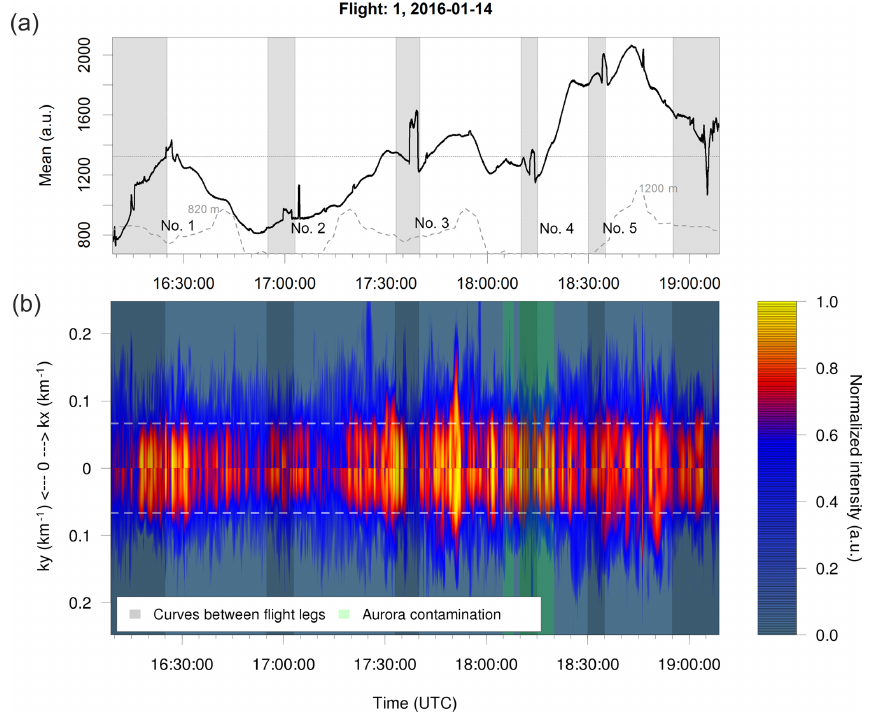
Figure 8. (a) Time series of integrated intensity per FAIM image. The grey areas refer to turning manoeuvres and should be excluded from further analysis. The grey line shows the orography. (b) Two-dimensional FFT spectra versus time: in the upper (lower) part the spectral intensity depends on the zonal (meridional) wave number. This plot is created by summing up the significant spectral intensities over the meridional (zonal) wave numbers for each image. The colour bar is normalized in a way that the different spectra are comparable within one flight (logarithm to the basis of 10 is applied to each spectrum, mean and standard deviation over these values of the whole time series are calculated, and values higher or lower than the mean plus or minus 2 times the standard deviation are set to 1 or 0). The horizontal line marks the wavelength of 15km.